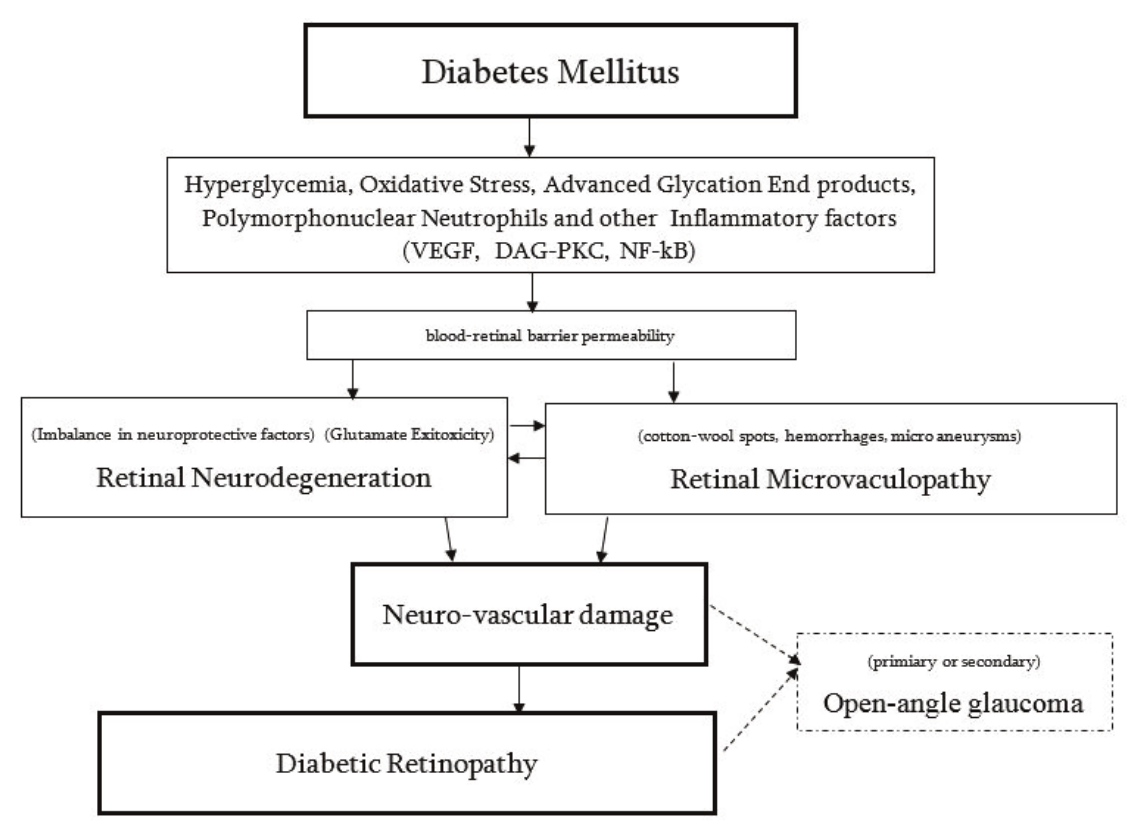
Figure 5: Key mechanisms leading to the DR [18]. Schematic representation of the main mechanisms leading to Diabetic Retinopathy, where neural and vascular damage leads to